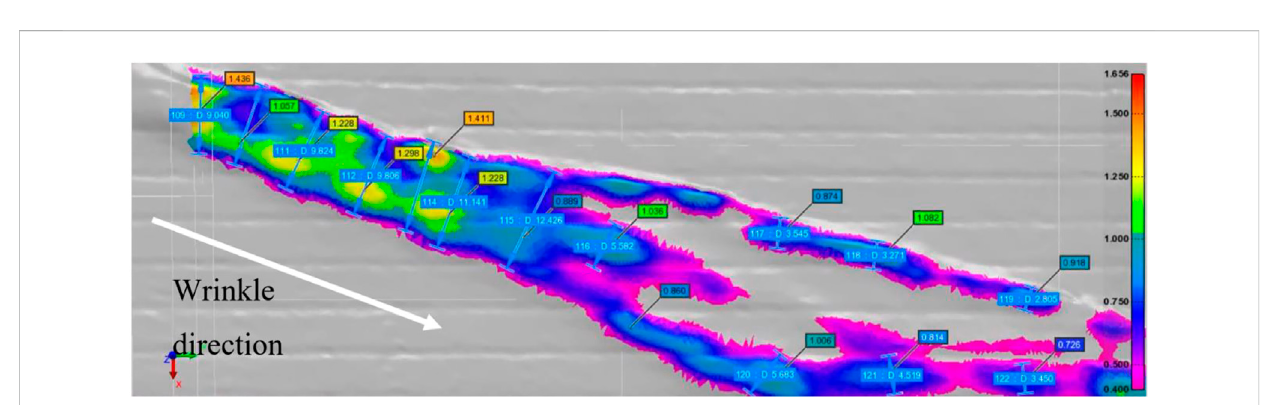
FIGURE 3 Example of sampling points for wrinkle width and height shown along wrinkle length with colour map showing out-of-plane heights.